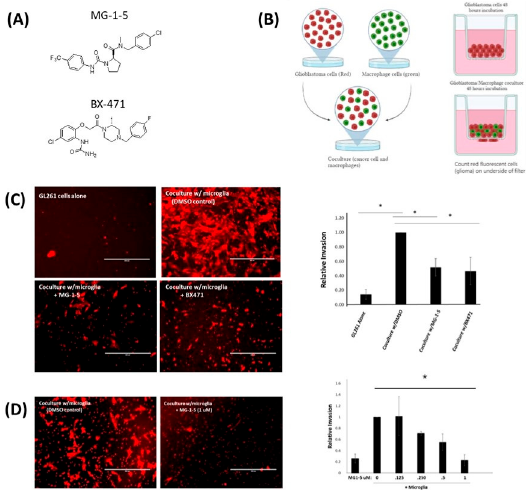
Figure 1. Blockade of CCR1 inhibits microglia stimulated glioma cell invasion. ( A ). Compounds and structures used in the experiment. ( B ) Experimental design of Coculture assay utilized to measure microglia stimulated glioma invasion. GL261 ‐ mCherry and MG ‐ GFP (cells not shown) were cocultured on invasion chambers for 48 h in the absence and presence of CCR1 antagonists ( C ). Images and quantitation of invasion assay. * Indicates p value of ≤ 0.05. Data are mean − /+ SEM (n = 3) ( D ) Images of GL261 m ‐ Cherry invasion in DMSO (control) and 1 uM MG ‐ 1 ‐ 5 and quantitation of dose dependent effect of MG ‐ 1 ‐ 5 on glioma invasion.